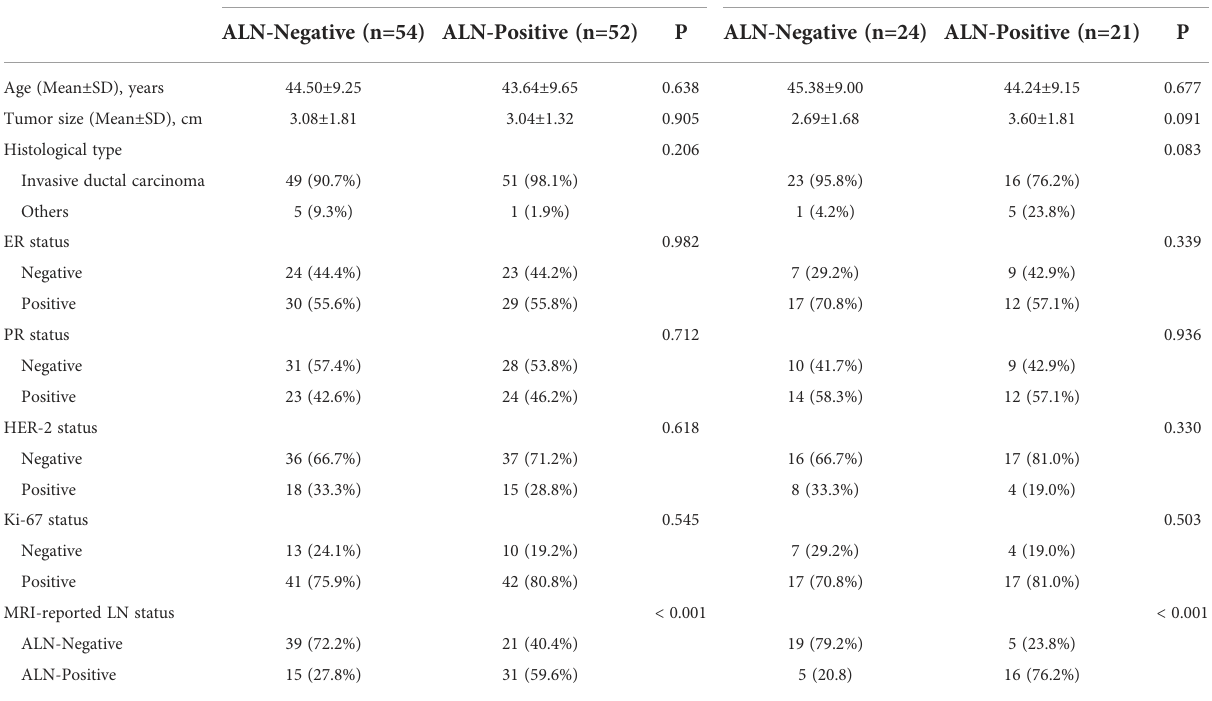
TABLE 1 Clinical characteristics in training and test cohorts.